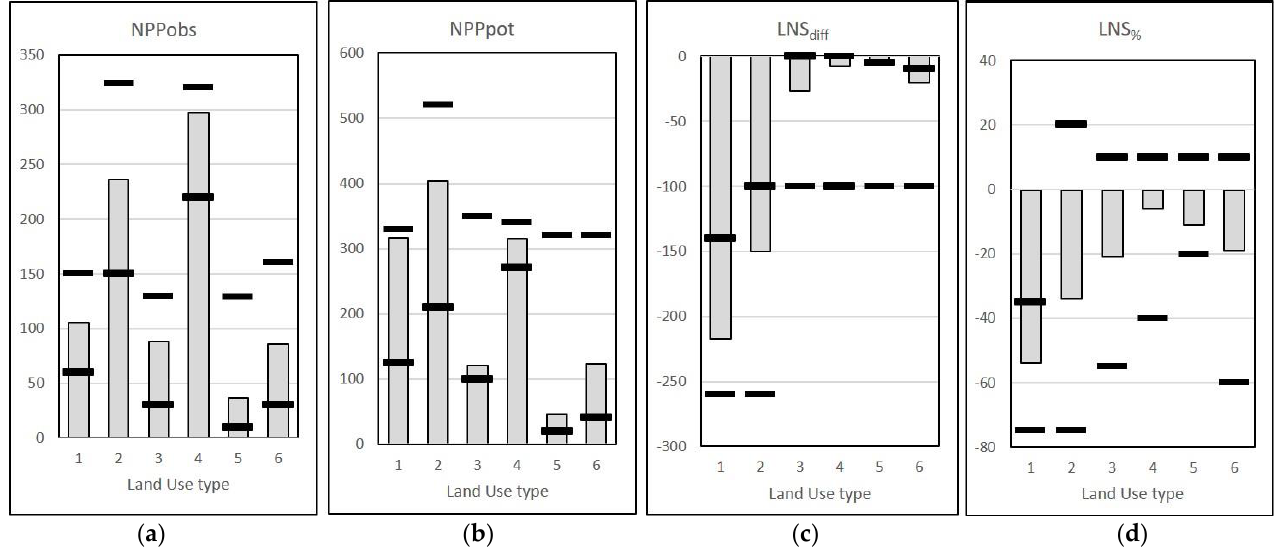
Figure 5. Modal values (columns) and ranges (bars) of ( a ) NPP obs , ( b ) NPP pot , ( c ) LNS diff , and ( d ) LNS % , in gC m −2 yr −1 . Bars indicate the upper and lower inflection points in the frequency distributions—not confidence limits. Land Use Types: 1, Savannization; 2, Intensive Cultivation; 3, Bedouin Cultivation; 4, Pine Plantation; 5, Pasture; 6, Settlements.